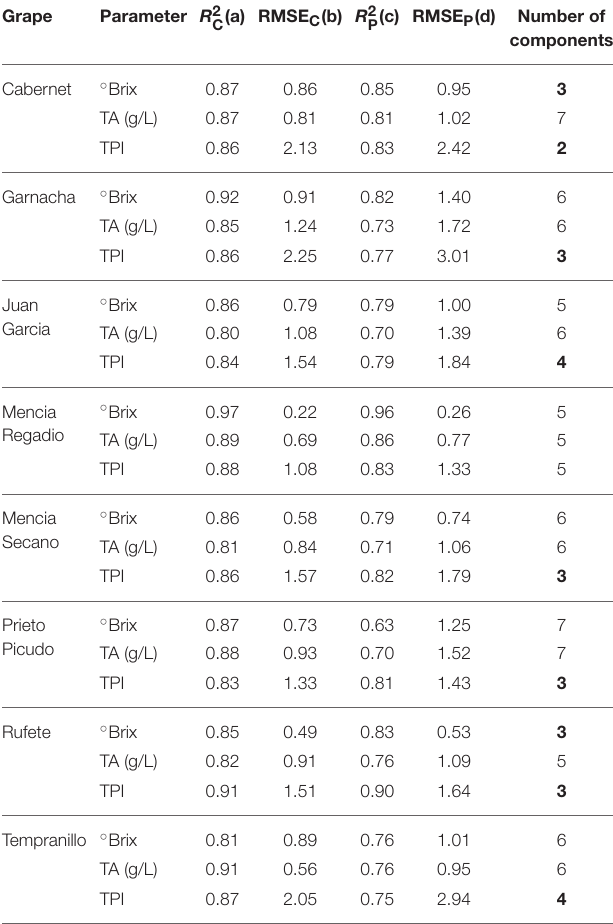
TABLE 1 | Results of the PLS-1 regression models correlating the chemical parameters and the signals of the sensors.